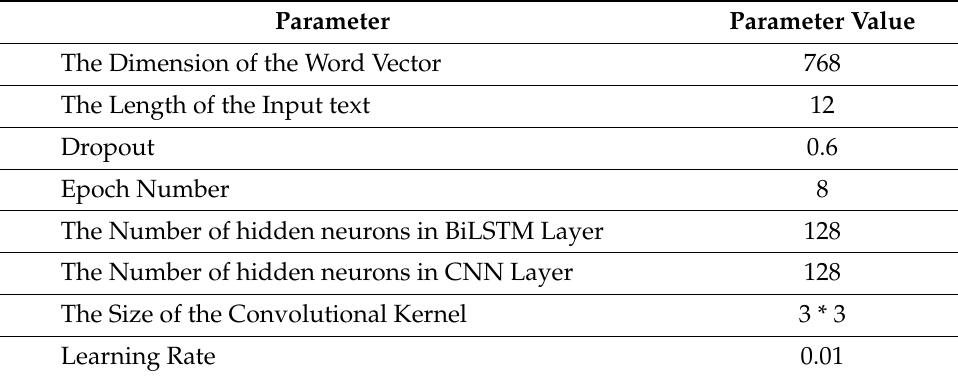
Table 5. Model parameter setting table.